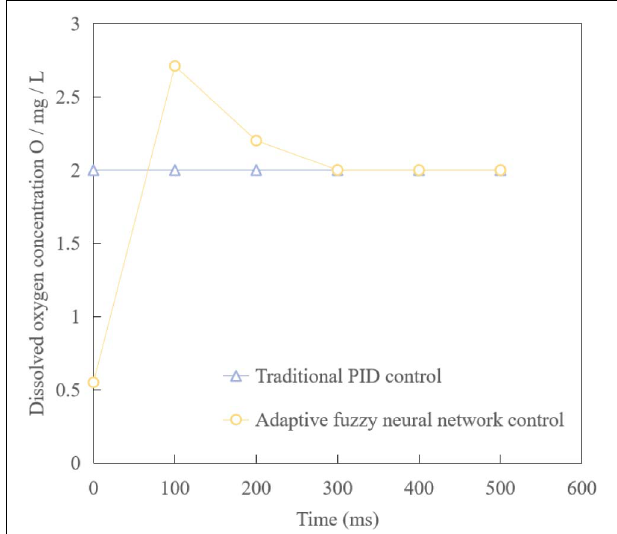
FIGURE 9 | Output control curve of dissolved oxygen concentration.